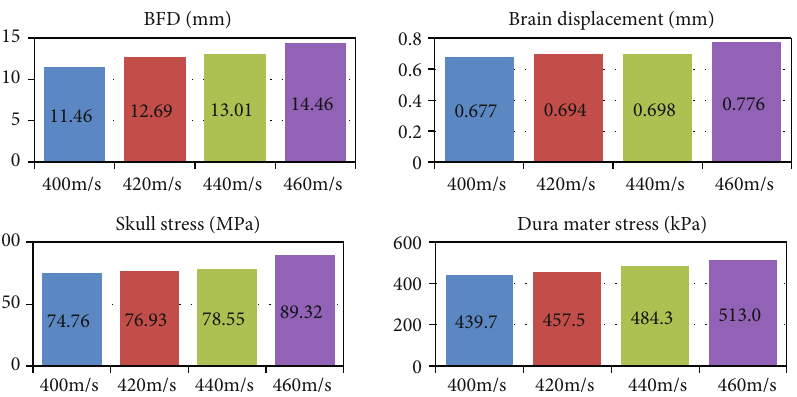
Figure 12: Comparison of peak values impacted by di ff erent projectiles.